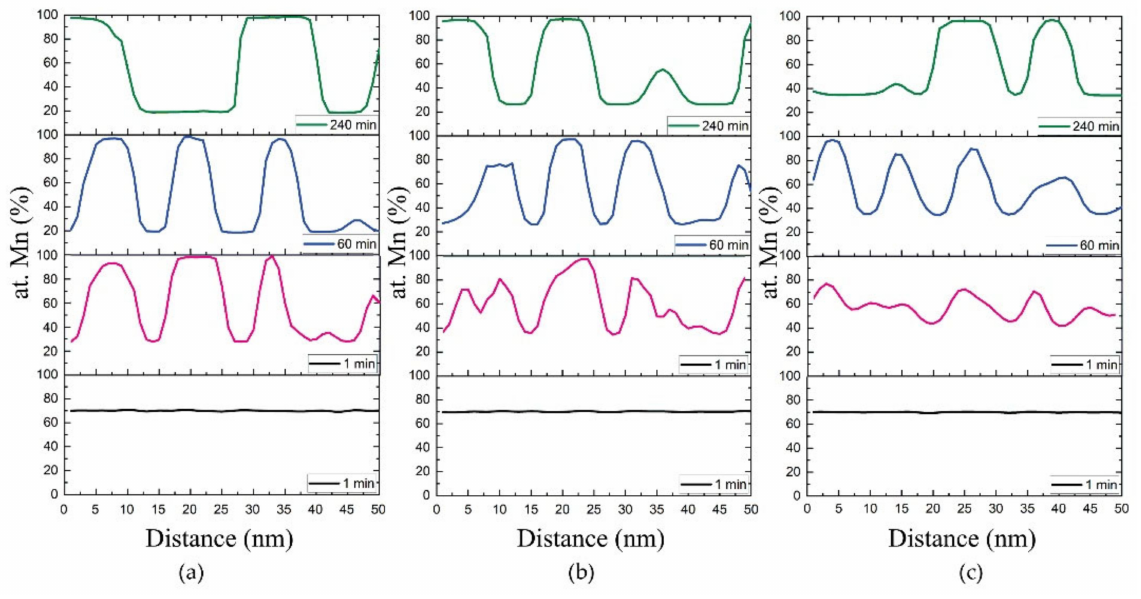
Figure 5. Calculated concentration profiles of Mn-30 at. %Cu alloys aged at ( a ) 300 ◦ C, ( b ) 400 ◦ C, and ( c ) 500 ◦ C for different times.